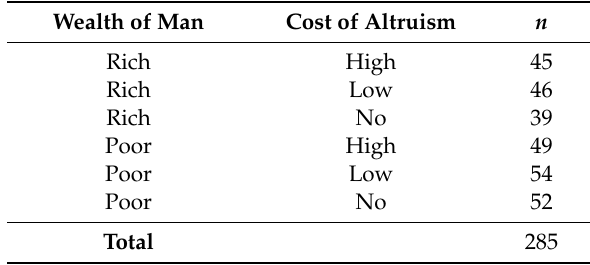
Table 2. The number of participants in each of the conditions.